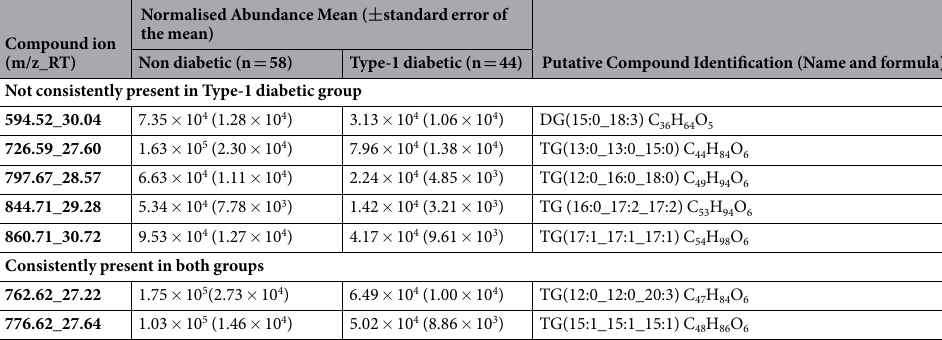
Table 2. Comparison of ion distributions in diabetics and non-diabetics (positive ionisation). Compound ions with significantly different normalised abundance (mean ± standard error of the mean) in positive ion chromatograms of non-diabetic (n = 58) and type-1 diabetic (n = 44) volunteers. Neutral mass of the putatively identified compounds was calculated by subtracting NH 4 + adduct ion (m/z 18.033). Two triglycerides (TG) were consistently present in both groups. One diglyceride (DG) and four other triglycerides were consistently present only in the non-diabetic group. The normalised abundance of these seven compound ions was more than twofold higher (P < 0.05) in non-diabetic volunteers than in type-1 diabetic volunteers.